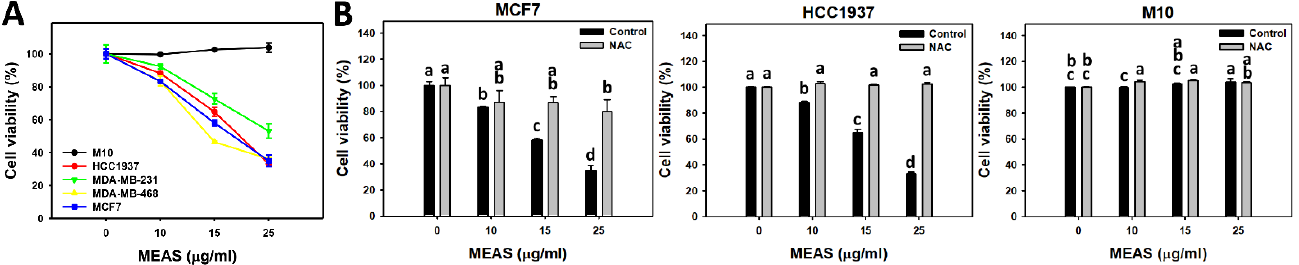
Figure 2. MEAS decreased the viability of several kinds of breast cancer cells. ( A ) Cell viability of MEAS at 24 h MTS assay. Except for normal breast cells (M10), others were TNBC and non-TNBC cells. ( B ) Cell viability of NAC/MEAS at 24 h MTS assay. NAC/MEAS represents NAC pretreatment (10 mM, 1 h) and MEAS posttreatment for 24 h. Data = mean ± SD ( n = 3). Statistical software assigned low-case letters to each treatment. When the letters of different treatments overlapped, the results were significant ( p < 0.05). In the example of Figure 2B (MCF7 cells), MEAS treatments at 0, 10, 15, and 25 μg/mL labeled with “a, b, c, and d” differ significantly, determined by non-overlapping conditions. MEAS and NAC/MEAS treatments of MCF7 cells at 10 μg/mL MEAS labeled with “b and ab” show a non-significant difference because they overlapped with “b”, while at 15 μg/mL MEAS labeled with “c and ab” show a significant difference.